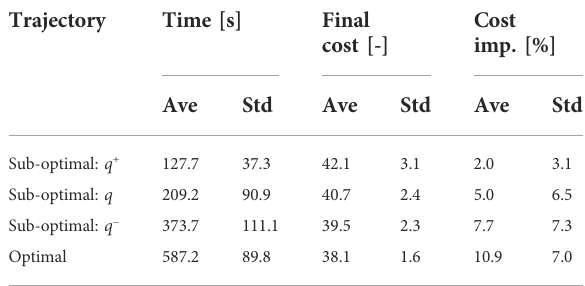
TABLE 3 Simulation result in terrain roughness 0.207 (goal A): C 0 =43.0 ± 3.1.